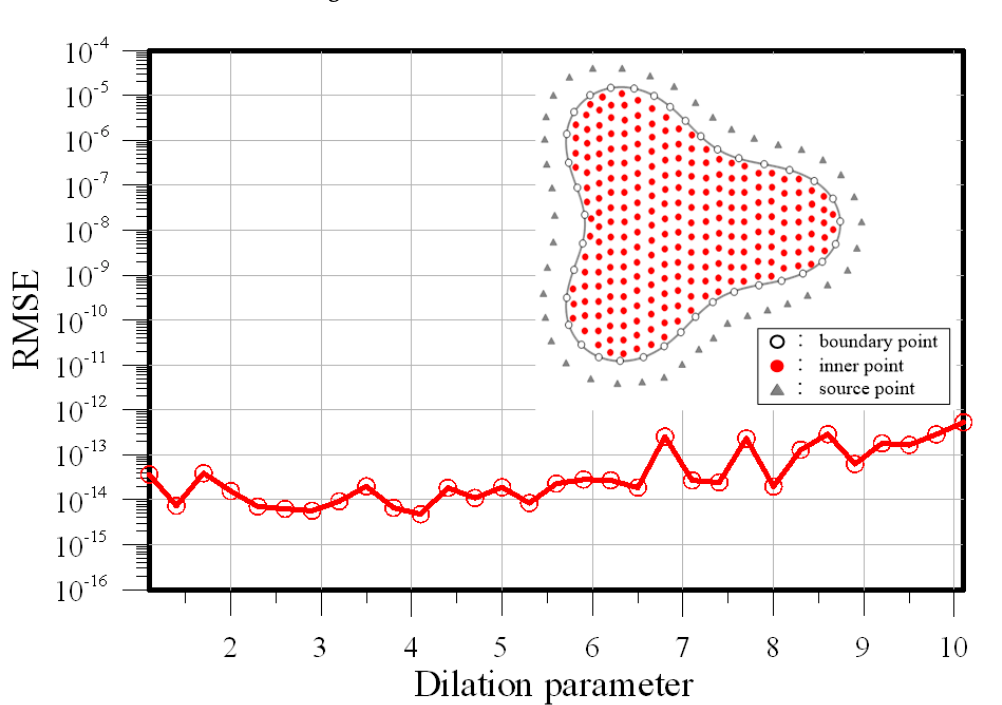
Figure 9. Dilation parameter versus RMSE.